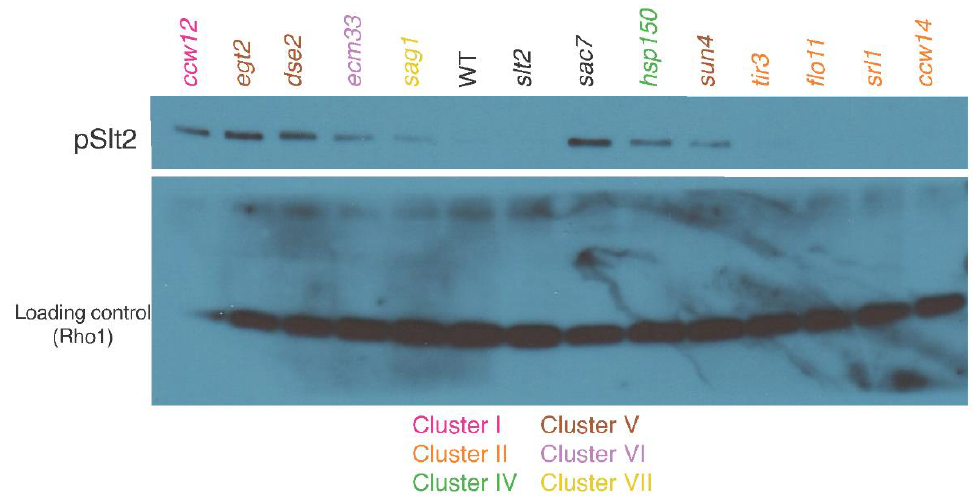
Figure 3. Western blotting of phosphorylated Slt2 (pSlt2, upper panel) and loading control Rho1 (lower panel). BY4743 (WT); ccw12 ∆ / ccw12 ∆ (cluster I); ccw14 ∆ / ccw14 ∆ , flo11 ∆ / flo11 ∆ , srl1 ∆ / srl1 ∆ , and tir3 ∆ / tir3 ∆ (cluster II); hsp150 ∆ / hsp150 ∆ (cluster IV); dse2 ∆ / dse2 ∆ , egt2 ∆ / egt2 ∆ , and sun4 ∆ / sun4 ∆ (cluster V); ecm33 ∆ / ecm33 ∆ (cluster VI); and sag1 ∆ / sag1 ∆ (cluster VII) cells were examined for the presence of phosphorylated Slt2. Rabbit antibody against phospho-p42/44 MAPK (T202/Y204) and rabbit antibody against yeast Rho1 were used to detect the phosphorylated Slt2 and Rho1, respectively. slt2 ∆ / slt2 ∆ and sac7 ∆ / sac7 ∆ were used as negative and positive controls, respectively, for phosphorylated Slt2. Mutants are color-coded according to Gaussian mixture model clustering of morphological data (see Figure 1).